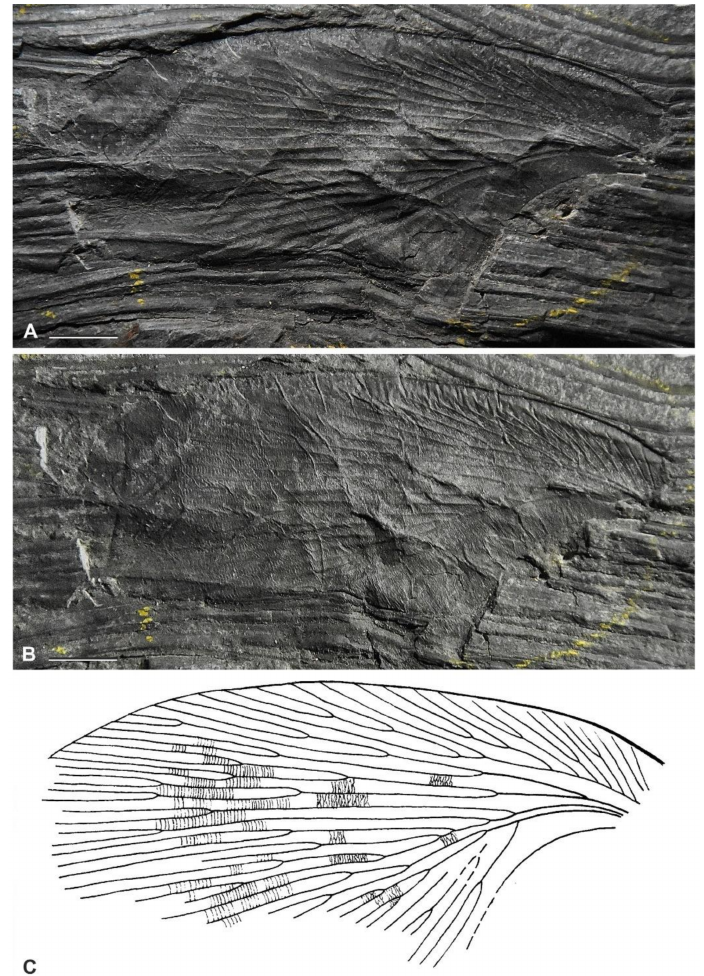
Figure 10. ( A – C )— Progonoblattina helvetica (Heer, 1864): type specimen of ‘ Etoblattina steinman- nii ’ Sterzel, 1904; Hinterohlsbach near Oppenau; ALUF 792-14; reconstructed length 52 mm; A— illumination perpendicular and B—parallel to the long wing axis; scale bars 5 mm; photo: